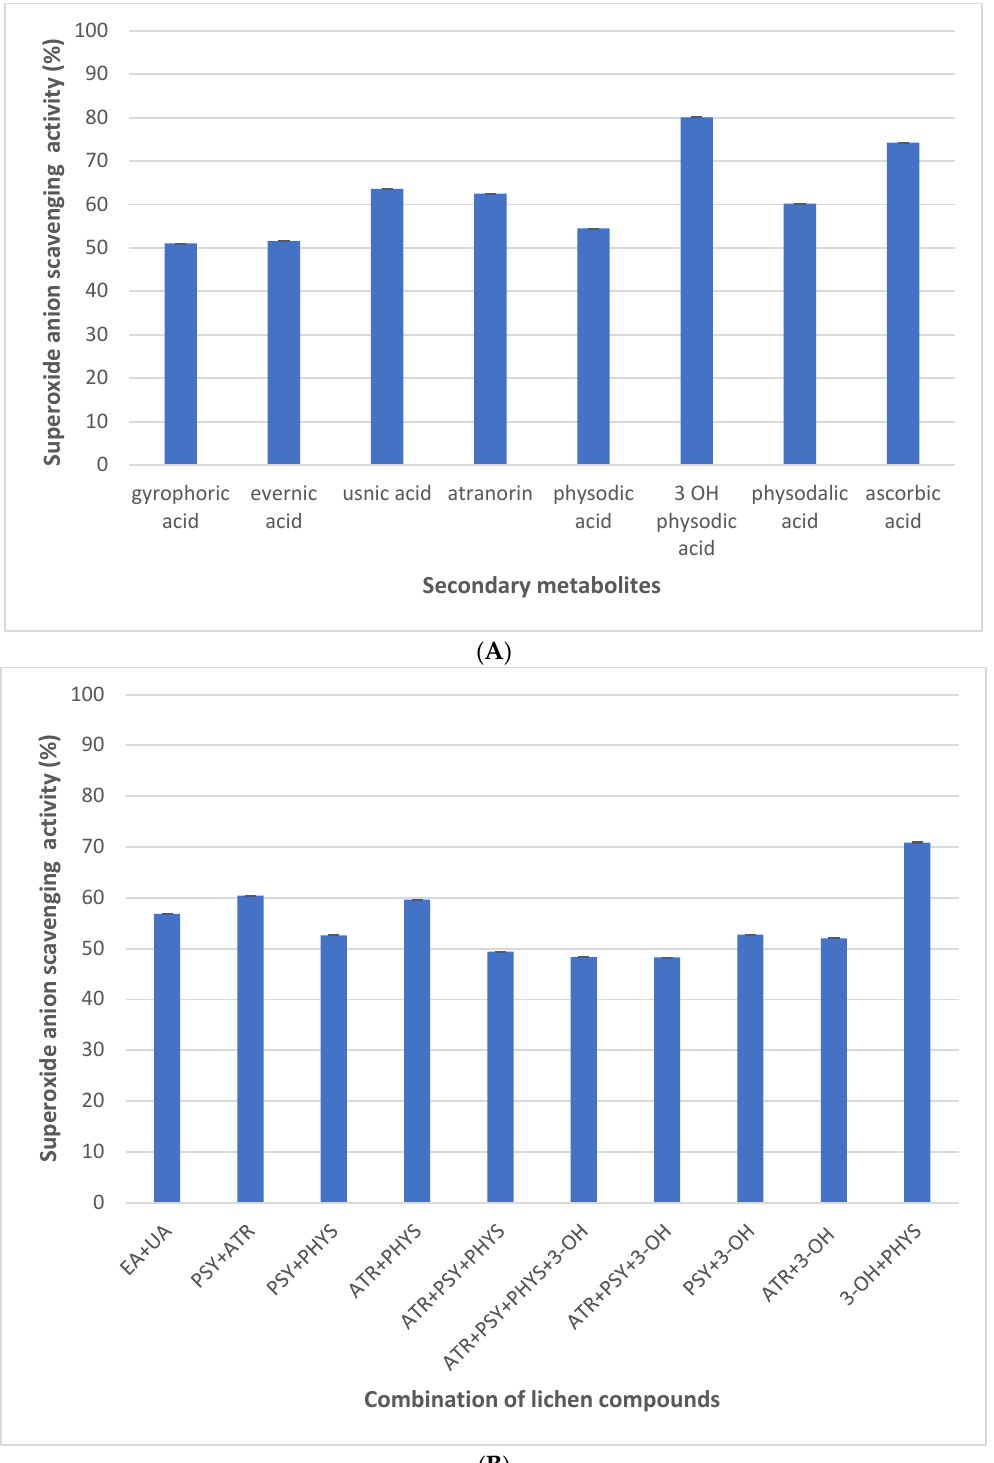
Figure 5. ( A ): Superoxide anion scavenging activity of lichen metabolites ( n = 3) and ascorbic acid was used as a reference compound; ( B ): superoxide anion scavenging activity showed via combination of lichen compounds ( n = 3). Abbreviations mean: EA (evernic acid), UA (usnic acid), PSY (physodic acid), ATR (atranorin), PHYS (physodalic acid), 3-OH (3-hydroxyphysodic acid.